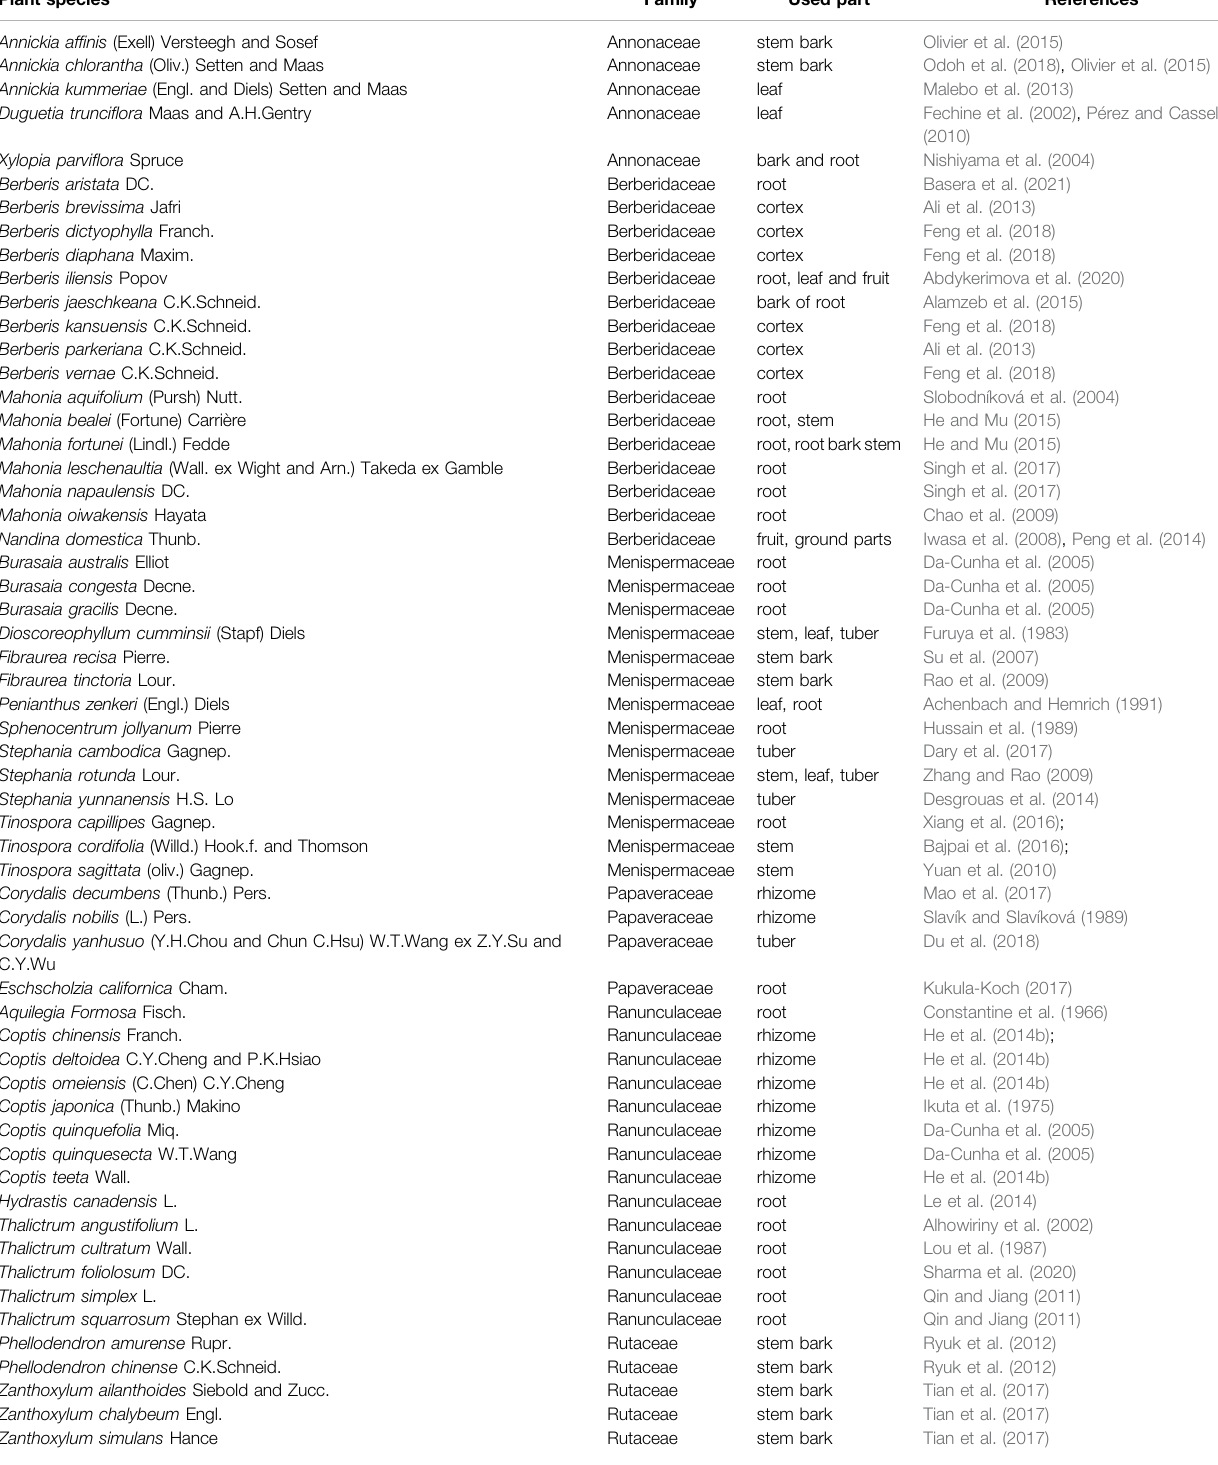
TABLE 1 | The plant sources of